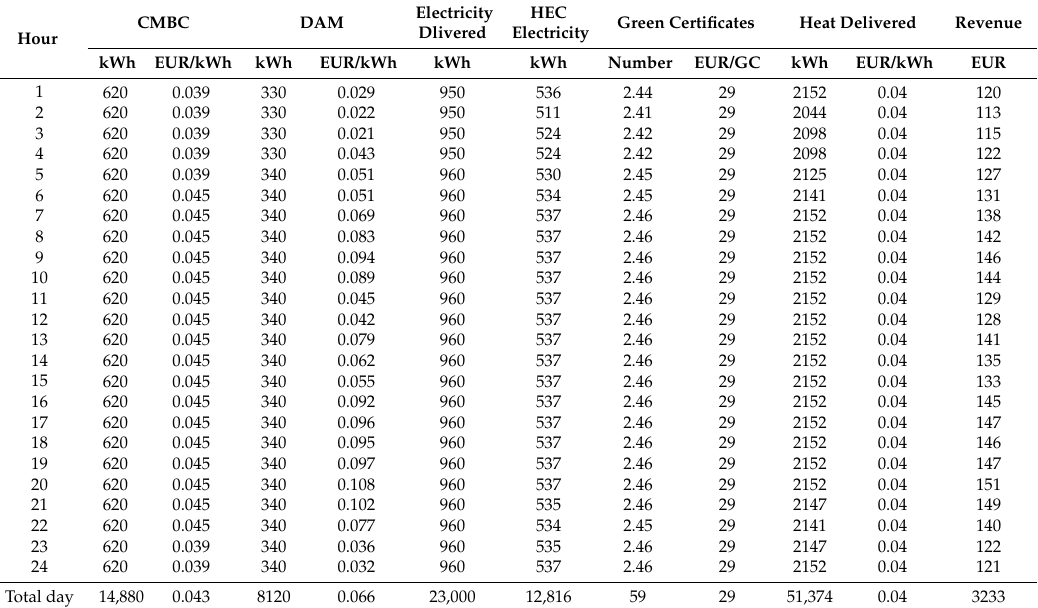
Table 1. An example of calculating revenue for the CHP plant operation at partial loads.